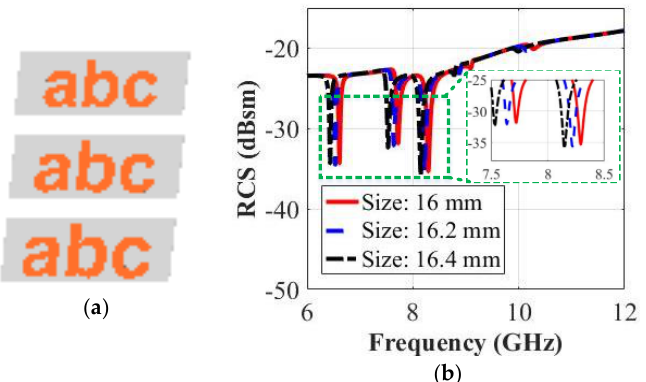
Figure 19. RCS simulation results of tag-abc written by different heights: ( a ) Different tags written by 16 mm, 16.2 mm and 16.4 mm sizes; ( b ) Co-polar HH RCS responses.